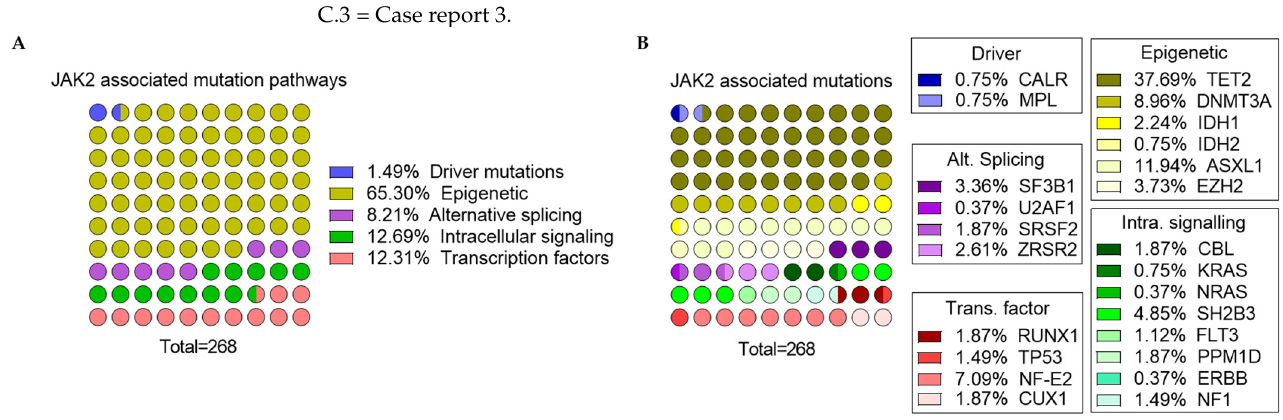
Figure 3. Overview of JAK2/MNAMs association in PV (total = 268 combinations) (based on Figure 2 related data). A visual dot plot representation of JAK2 associated mutations grouped by pathway ( A ) and individual affected gene ( B ) (each circle represents 1% of the total). Abbreviation: Alt. Splicing = Alternative Splicing; Intra. signaling = Intracellular signaling; Trans. factor = Transcription factor.